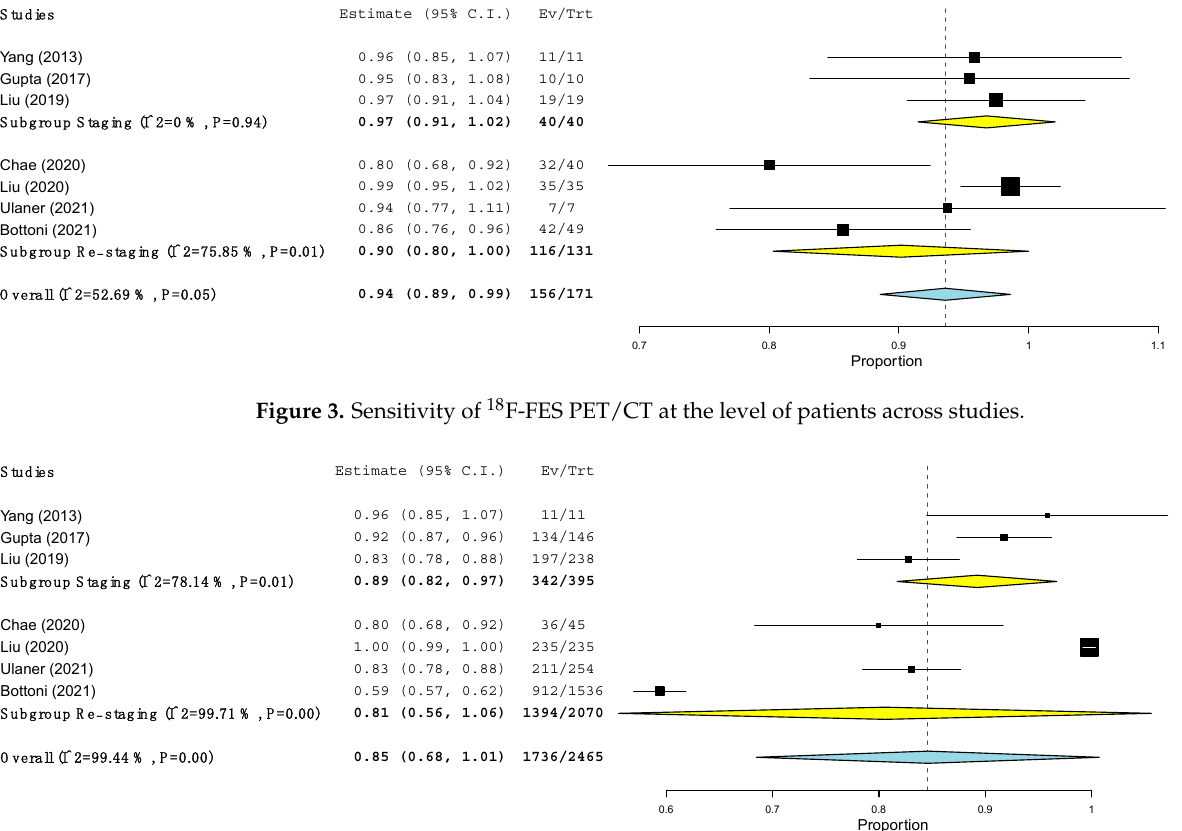
Figure 2. Sensitivity of 18 F-FDG PET/CT at the level of patients across studies.